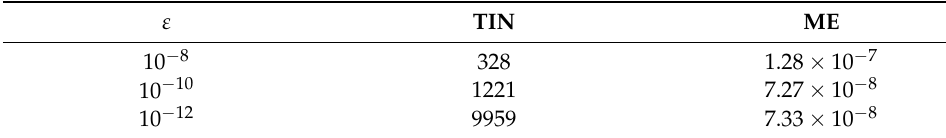
Figure 8. For Example 4: ME( u ) versus t in the time interval.